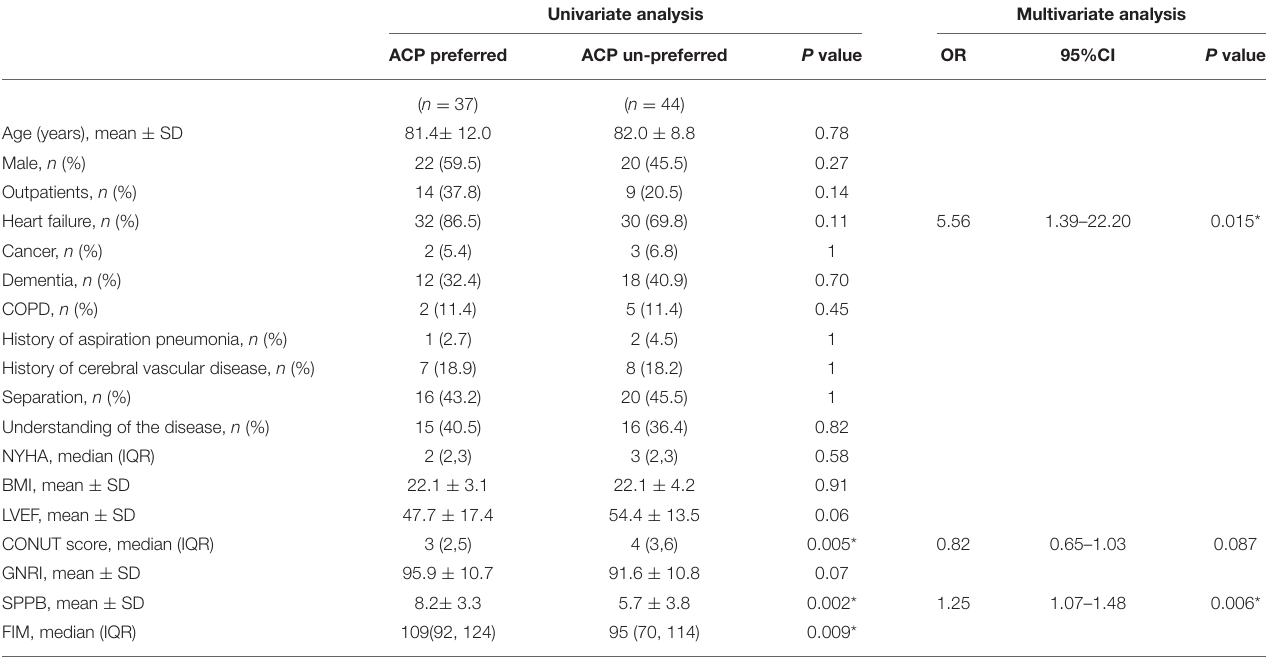
TABLE 3 | Univariate and multivariate analyses to predict preference of ACP.